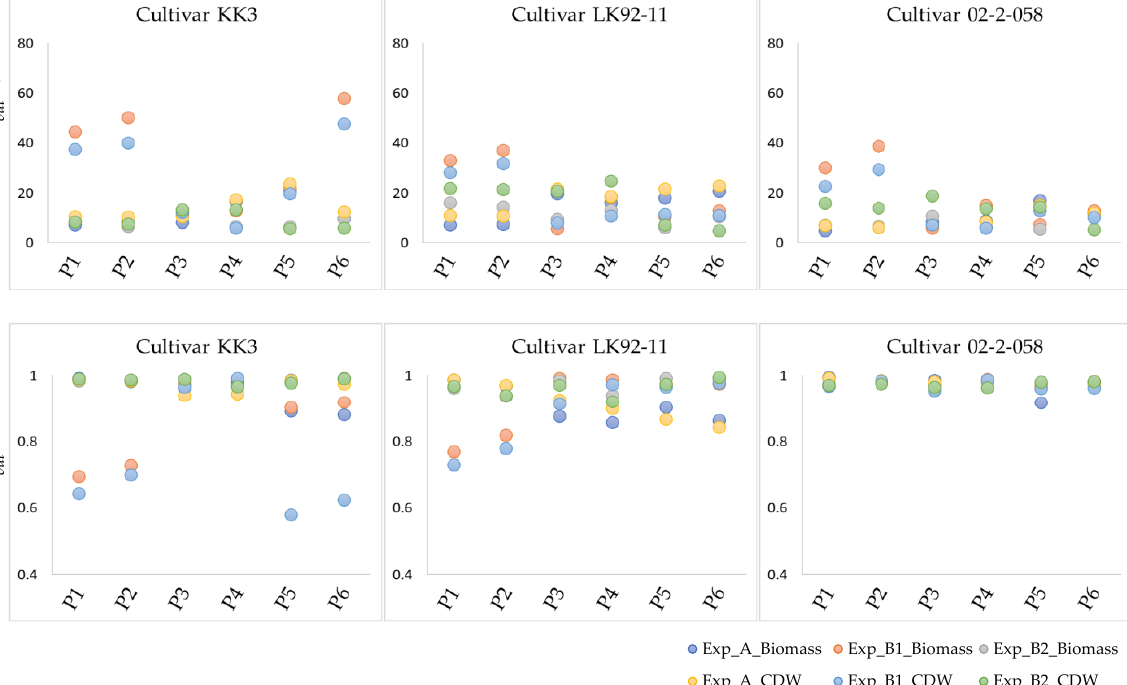
Figure 8. Dot plots of NRMSE val percentages and AI val values obtained during the validation of the parameter ensembles (P1, P2, P3, P4, P5 and P6) under each experimental condition corresponding to cultivars KK3, LK92-11, or 02-2-058. Each parameter ensemble of the dot plots indicated NRMSE val percentages and AI val values calculated between observed and simulated yields for six different cases (A_Biomass, A_CDW, B1_Biomass, B1_CDW, B2_Biomass and B2_CDW) of a single cultivar (see Figure 2).